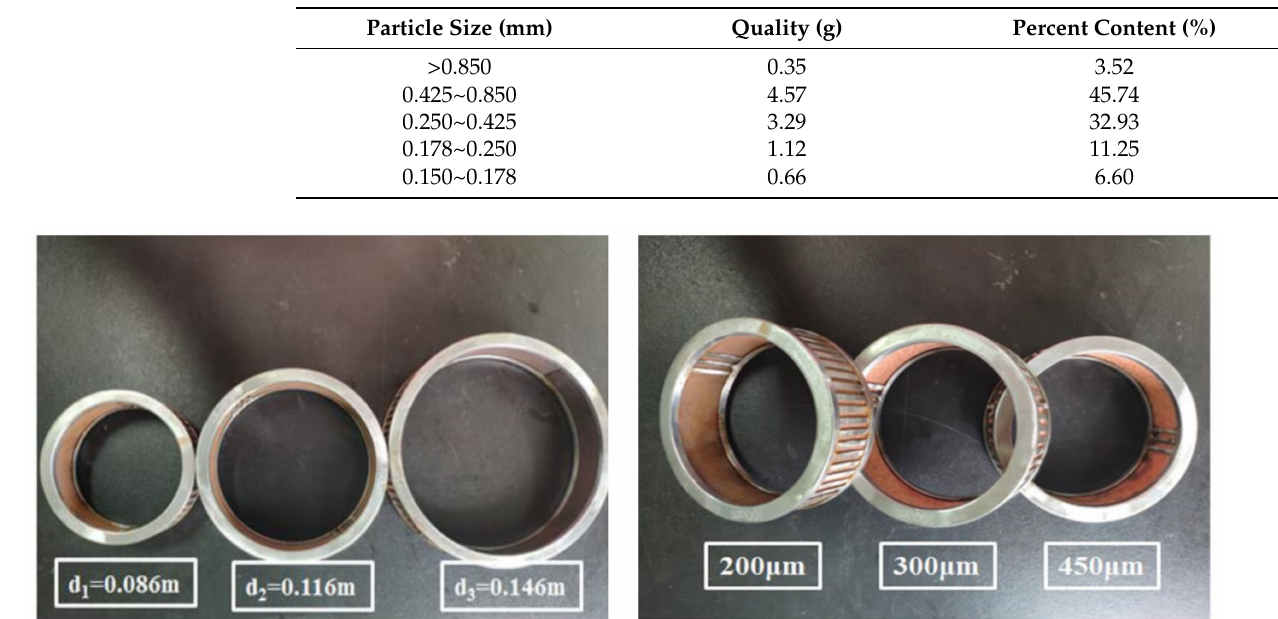
Table 1. Particle size distribution of hydrophobic associative polymers.